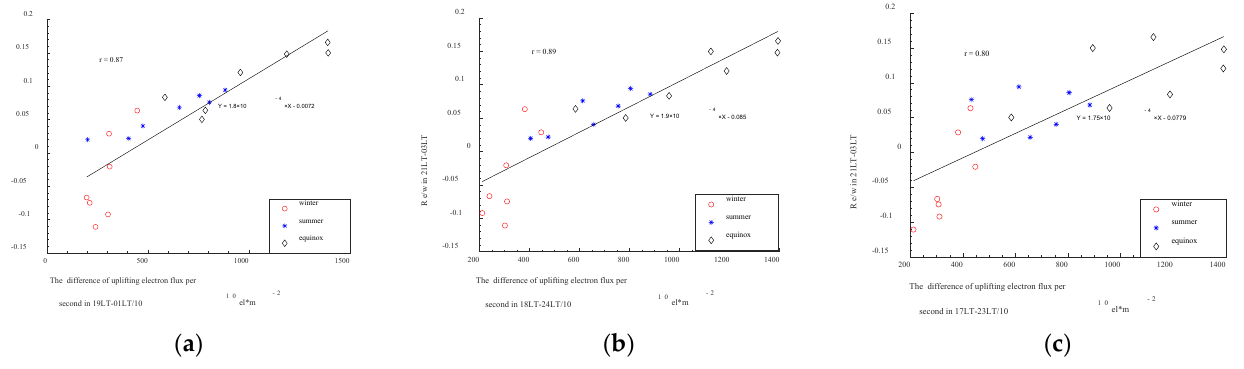
Figure 9. ( a ) Correlation between the TEC longitudinal difference index R e/w in 21LT–03LT and the difference of uplifting electron flux per second in 19LT–01LT in high solar activity years. ( b ) Correlation between the TEC longitudinal difference index R e/w in 21LT–03LT and the difference of uplifting electron flux per second in 18LT–24LT in high solar activity years. ( c ) Correlation between the TEC longitudinal difference index R e/w in 21LT–03LT and difference of uplifting electron flux per second in 17LT–23LT in high solar activity years.